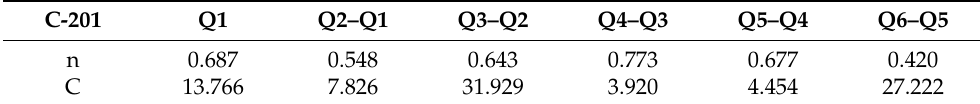
Table 1. Infiltration coefficient calculation result using the least square